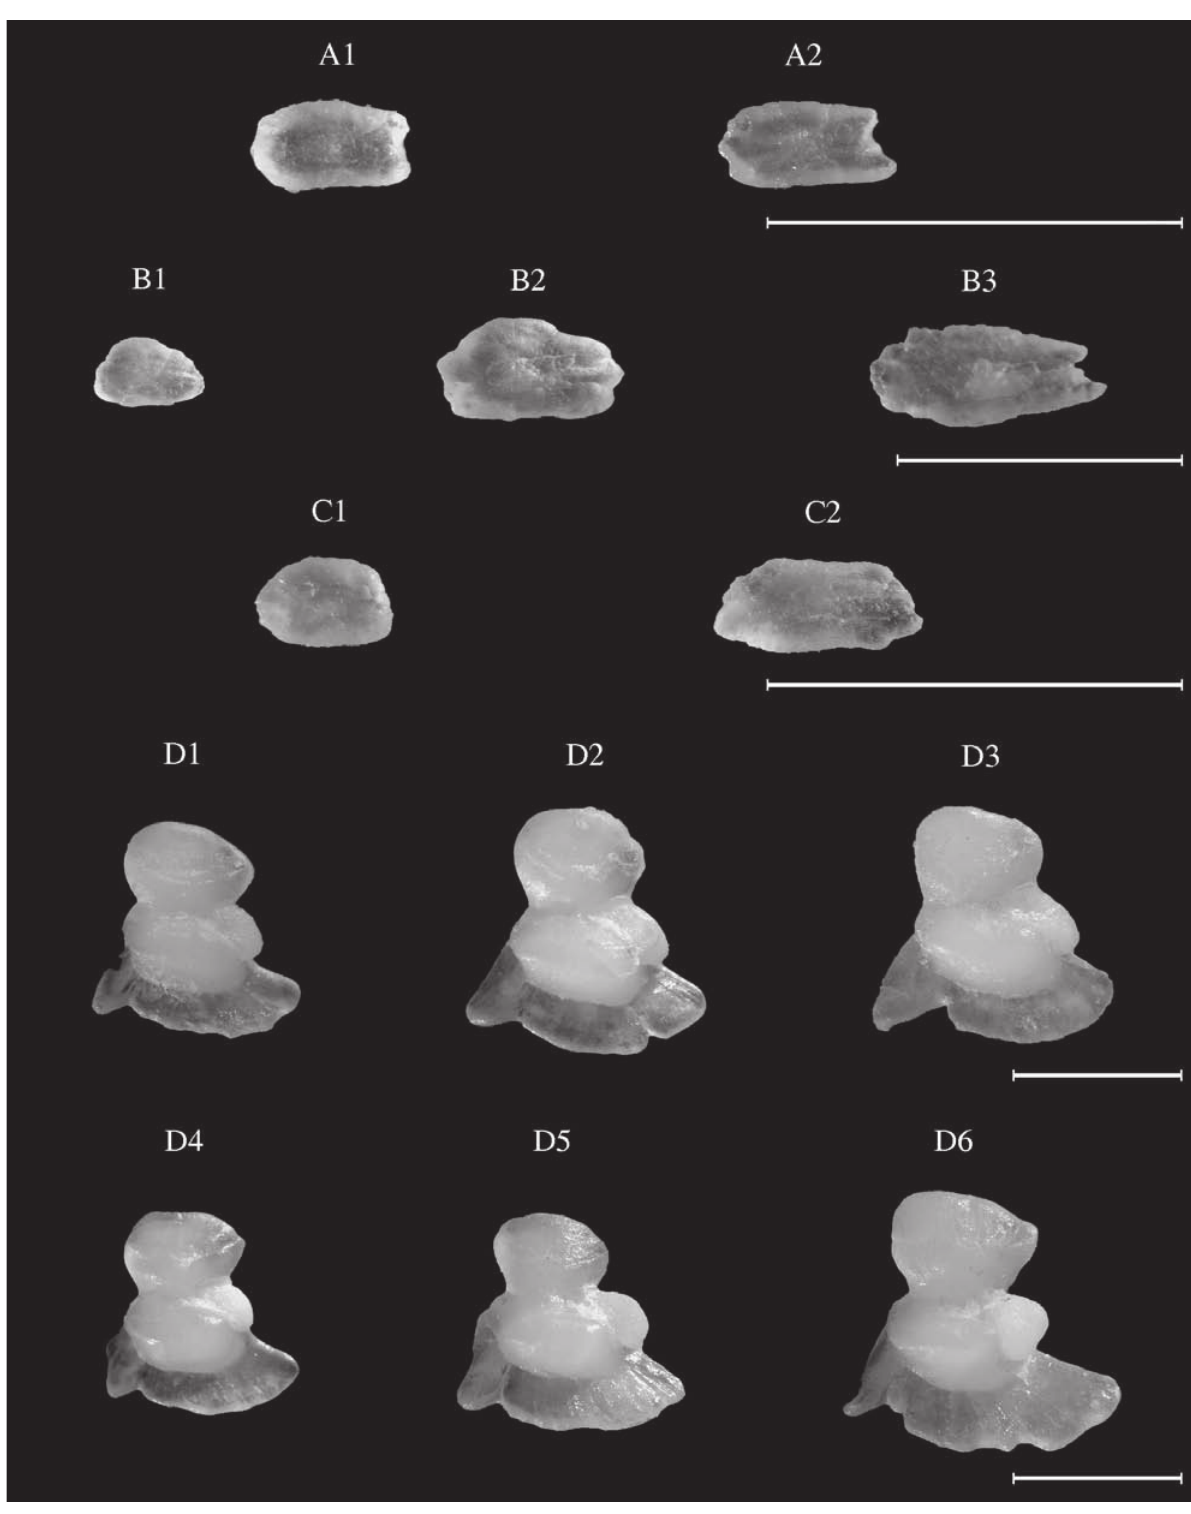
Fig. 40. – Syngnathus abaster (NEA). TL: A1, 14.5 cm; A2, 17.0 cm. Syngnathus acus (NEA). TL: B1, 18.8 cm; B2, 32.3 cm; B3, 41.8 cm. Syngnathus typhle (NEA). TL: C1, 23.3 cm; C2, 27.8 cm. Macroramphosus gracilis (NEA). TL: D1, 11.3 cm; D2, 13.9 cm; D3, 16.8 cm. Macroramphosus scolopax (NEA). TL: D4, 12.9 cm; D5, 15.5 cm; D6, 17.0 cm. Scale bar = 1